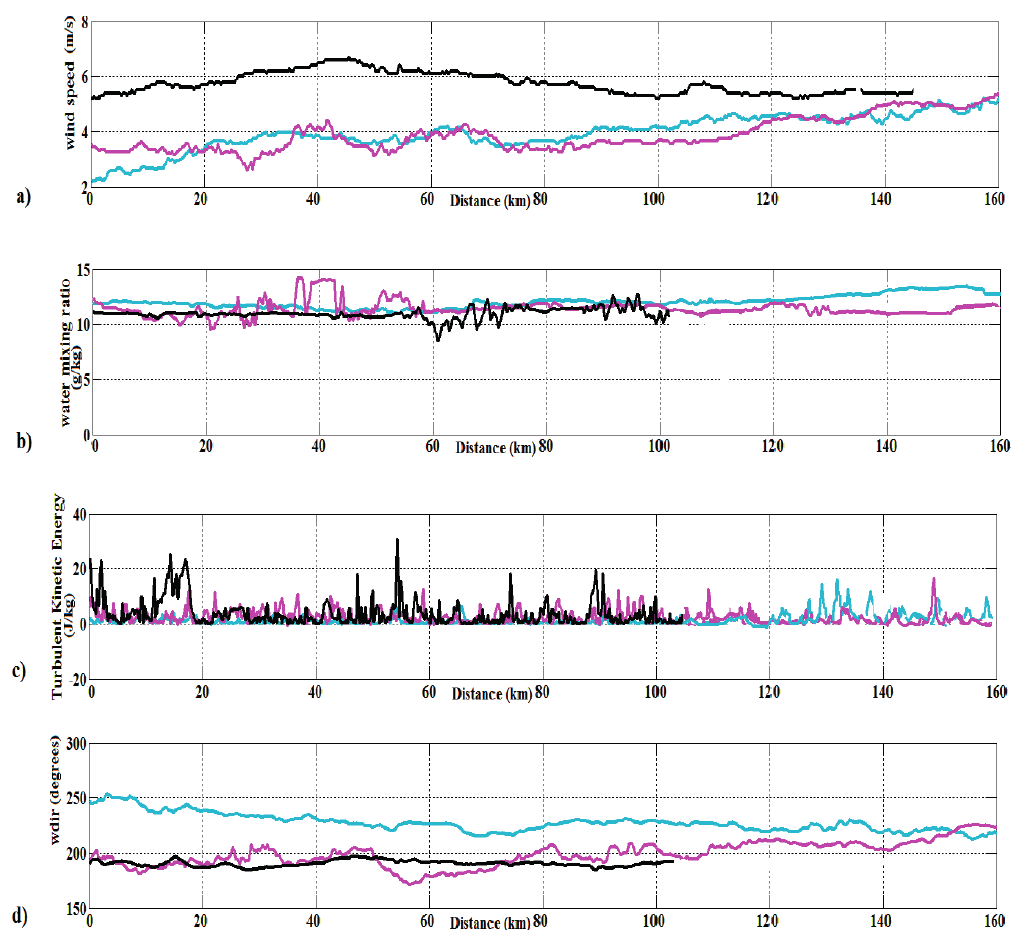
Figure 8. Physical characteristics of the NYC plume layer observed during transects by the P3 on 7/21 and 7/22 over the GOM. Shown are ( a ) horizontal wind speed (m/s); ( b ) water vapor mixing ratio (g/kg); ( c ) turbulent kinetic energy (J/kg); and ( d ) wind direction (degrees). Cyan lines designate observations from the coastal GOM transect on 7/21, magenta lines the oceanic GOM transect on 7/21, and black lines the central GOM transect on